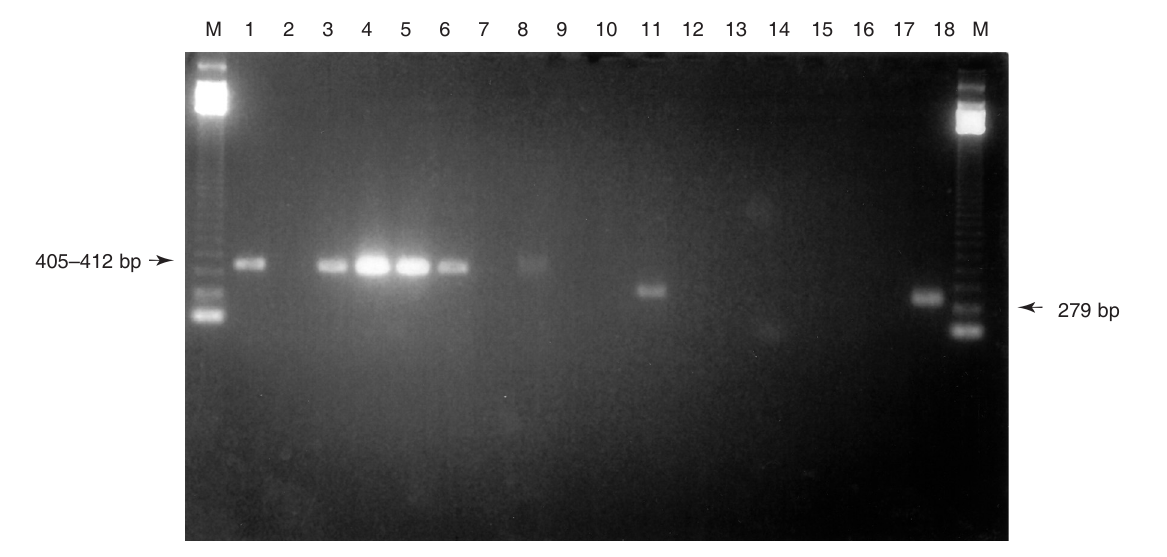
FIG. 1 A pCS20 PCR assay for E. ruminantium does not detect DNA from white tailed deer Ehrlichia . Agarose gel electrophoresis of PCR products with primers specific for WTDE show amplification of a DNA product of 405–412 bp from WTDE DNA (lanes 1, 3, 4, 5 and 6) but not from E. ruminantium Crystal Springs strain DNA (lane 8). Lanes 11 and 18 represent the results of the E. ruminantium -specific PCR assay. No amplification was detected when the pCS20 PCR was done on WTDE DNA (lanes 13–16) but amplification of a 279 bp fragment was seen with E. ruminantium DNA (lanes 11 and 18). Lane M is the 123 bp DNA markers. WTDE DNA samples are from white tailed deer from the following locations: lanes 1 and 6 are OS 82 (Ossabaw Island Georgia), lane 3 is MO (Missouri), lane 4 is Florida 2 and lane 5 is Florida 1. Lanes 2 and 17 are reagent blanks and 7, 9, 10, 12 and 17 are